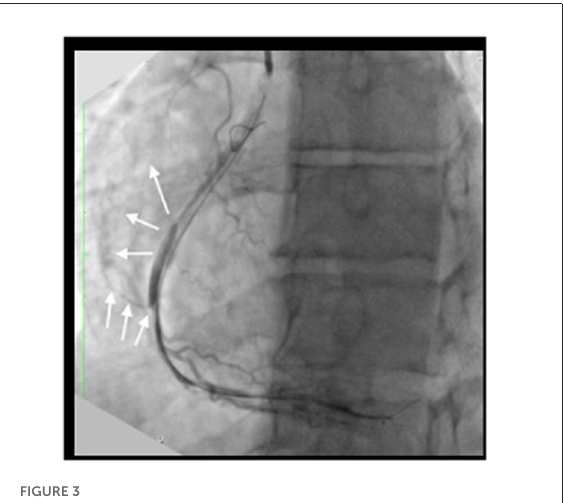
FIGURE3 Procedural complication: The angiography after CTO dilatation with compliant 2 x 15mm balloon at 10 atm showed coronary Ellis II perforation (white arrow) and diffuse type D dissection.